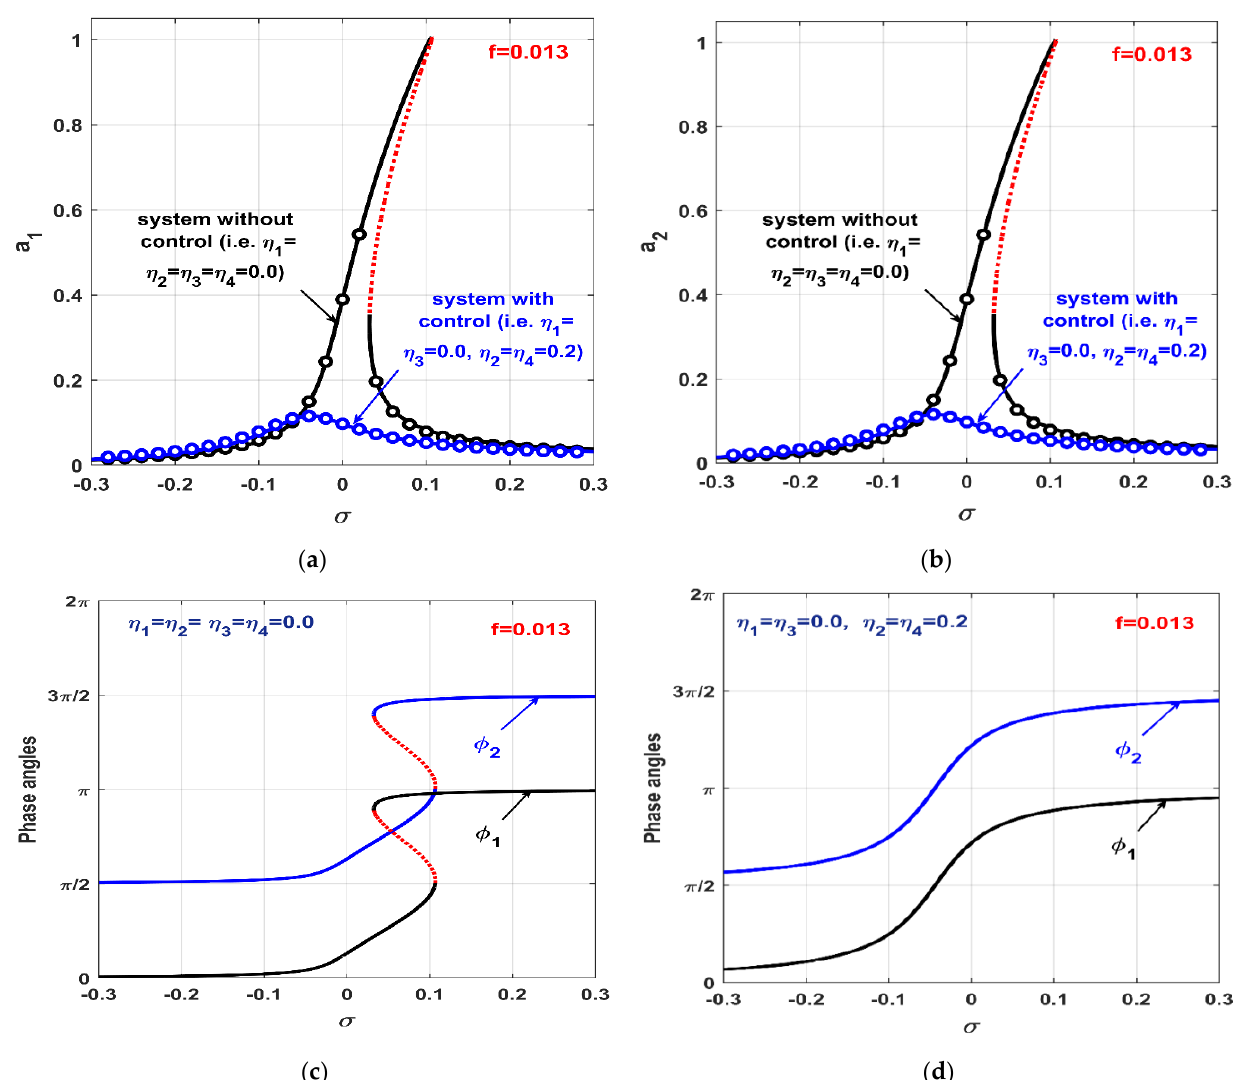
Figure 14. Vibration amplitudes and phase-angles of the twelve-poles rotor in the case of both the 𝑃𝐷 -control only and the 𝑃𝐷 + 𝐼𝑅𝐶 -control algorithm when 𝑓 = 0.013 : ( a , b ) vibration amplitudes ( 𝑎 (cid:2869) , 𝑎 (cid:2870) ) of the rotor, ( c ) phase angles ( 𝜙 (cid:2869) ,𝜙 (cid:2870) ) when 𝜂 (cid:2869) = 𝜂 (cid:2870) = 𝜂 (cid:2871) = 𝜂 (cid:2872) = 0.0 , and ( d ) phase angles ( 𝜙 (cid:2869) , 𝜙 (cid:2870) ) when 𝜂 (cid:2869) = 𝜂 (cid:2871) = 0.0, 𝜂 (cid:2870) = 𝜂 (cid:2872) = 0.2 .